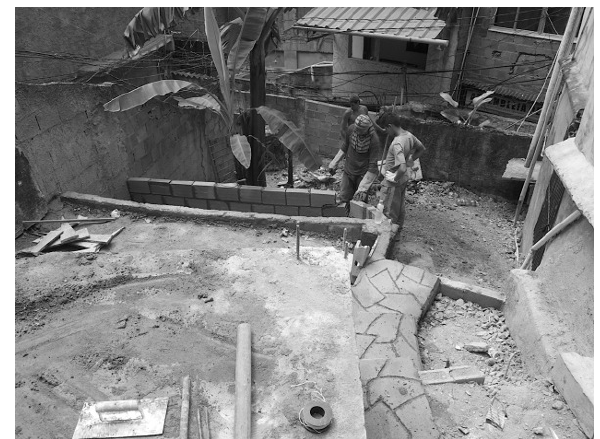
Figure 5. Trash buildup in the soil at the Rocinha Mais Verde space. Figure 6. Terracing Rocinha Mais